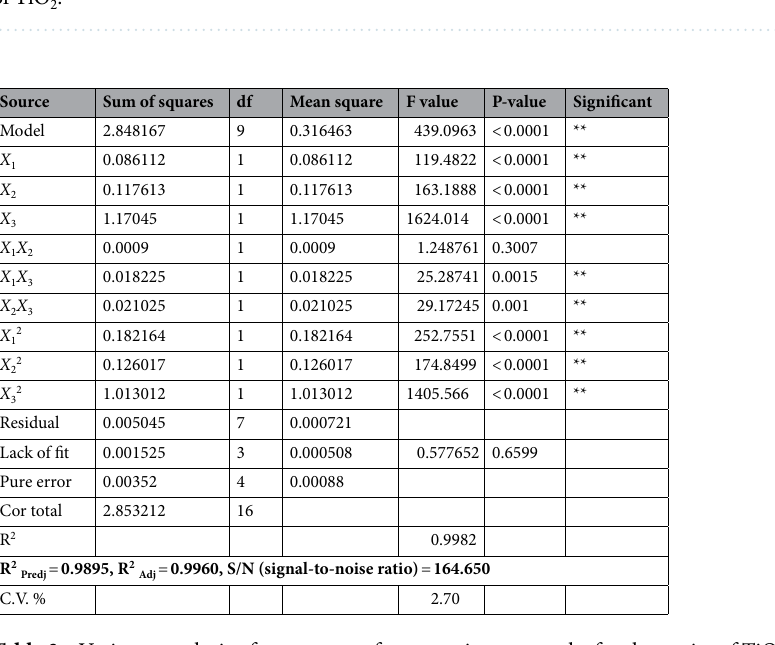
Table 3. Variance analysis of response surface experiments results for the purity of TiO 2 . *Indicated that it had a significant impact on the results (P < 0.05), **Indicated that it had a very significant impact on the